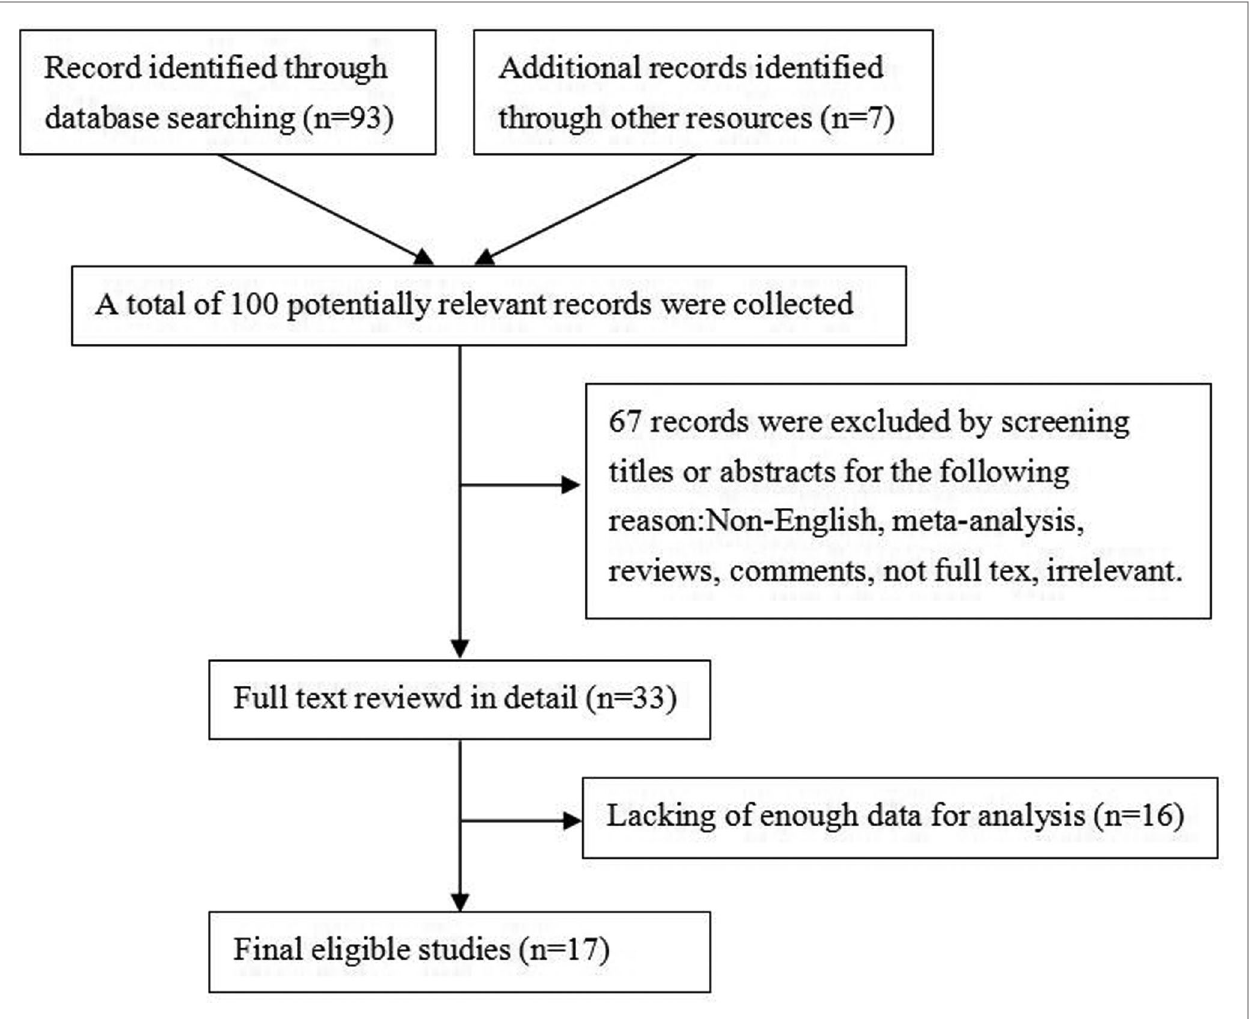
FIGURE 1 | Literature screening